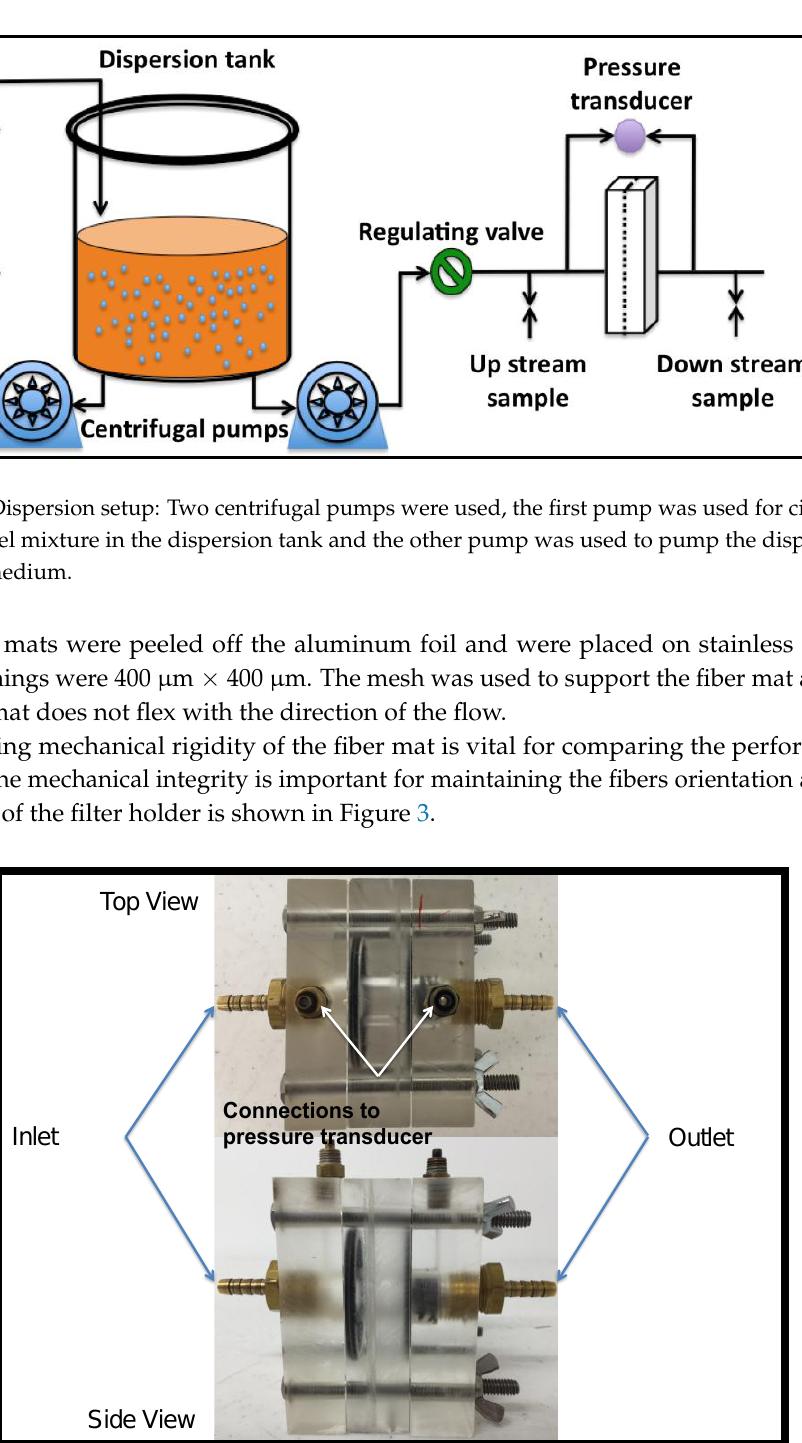
Figure 3. Plexiglas filter holder used to conduct liquid-liquid experiments. The holder consists of three pieces, two pieces for the inlet and outlet fittings and the fittings for the pressure transducer. The third piece has O-rings to insure proper sealing. The electrospun membrane is held inside the Plexiglas holder with about 2.2 cm opining diameter available for liquid flow.